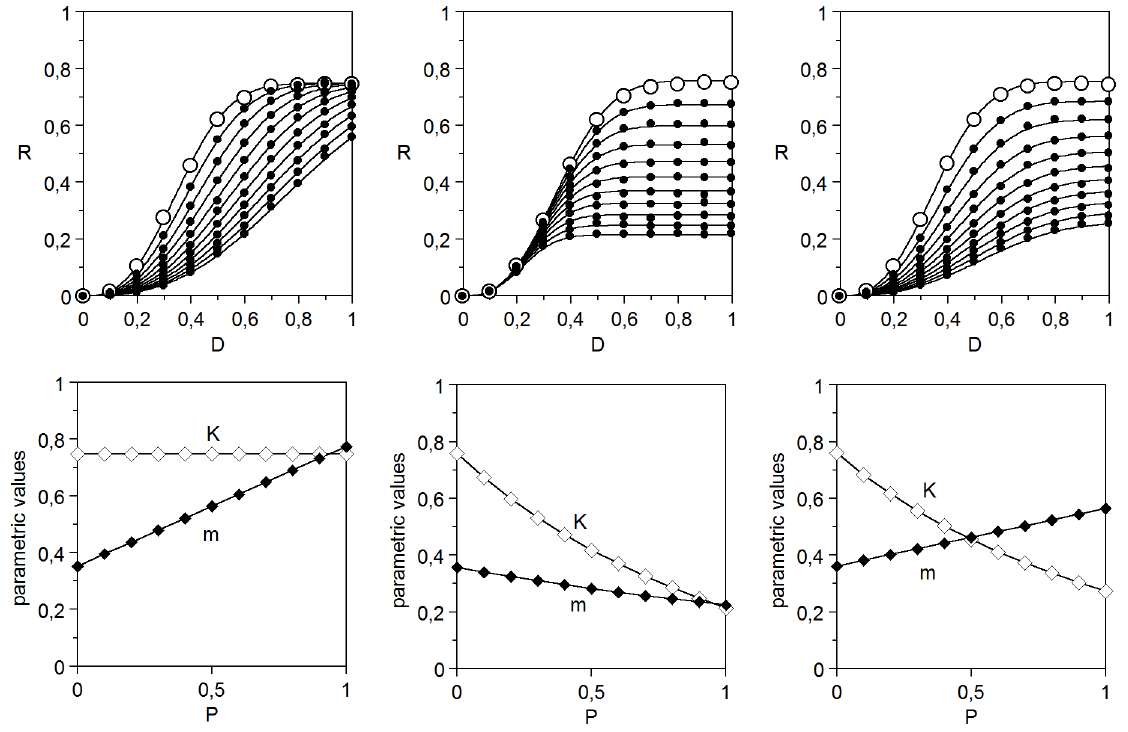
Figure 4. Effect of a perturbator on the response ( R ) to a same dose series ( D ) of an effector and the parameters of the model (22). The three cases in which the perturbation depresses the response are illustrated: reduction of the effective dose corresponding to the nominal one (left), reduction of the number of active receptors (canter), and increase of the threshold (right). Dots are simulated results in the absence ( # ) and N ) of increasing concentrations of the perturbator, and lines the respective fittings to model (22). See also tables 2 and 3. presence (